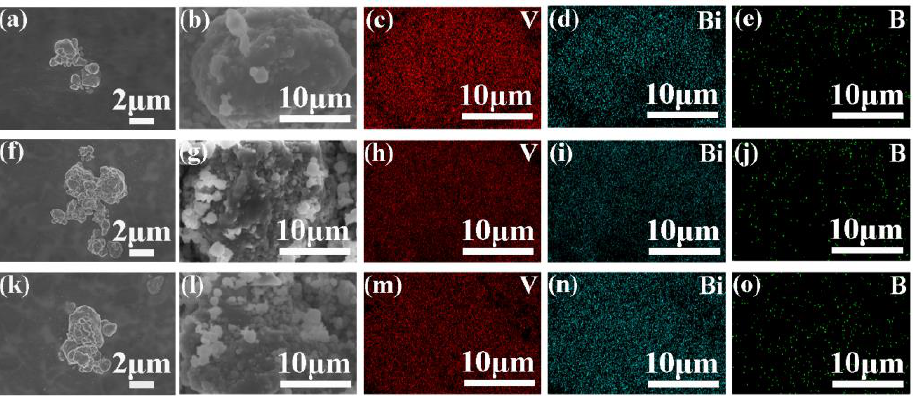
Figure 2. FE-SEM images of LVBB: ( a , b ) LVBB5 ( f , g ) LVBB7.5 ( k , i ) LVBB10; EDS spectrums of V, Bi and B element distribution in the field of view area of corresponding FE-SEM images: ( b – e ) LVBB5, ( g – j ) LVBB7.5, ( l – o ) LVBB10. The LVBB glass was ball-milled for 5 h prior to FE-SEM observation.